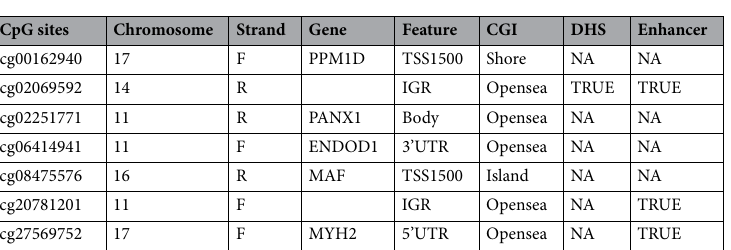
Figure 2. Identification of independent prognostic CpG sites. ( A ) lasso coefficient profiles of the methylation sites. A coefficient profile plot was produced against log(lambda) sequence. ( B ) Ten-fold cross-validation for selection of the parameter λ. ( C – I ) K–M survival analysis of cg00162940, cg02069592, cg02251771, cg06414941, cg08475576, cg20781201, cg27569752 in the TCGA–TGCT cohort, respectively. The cohort was separated into high and low groups according to the median β value of each CpG site.